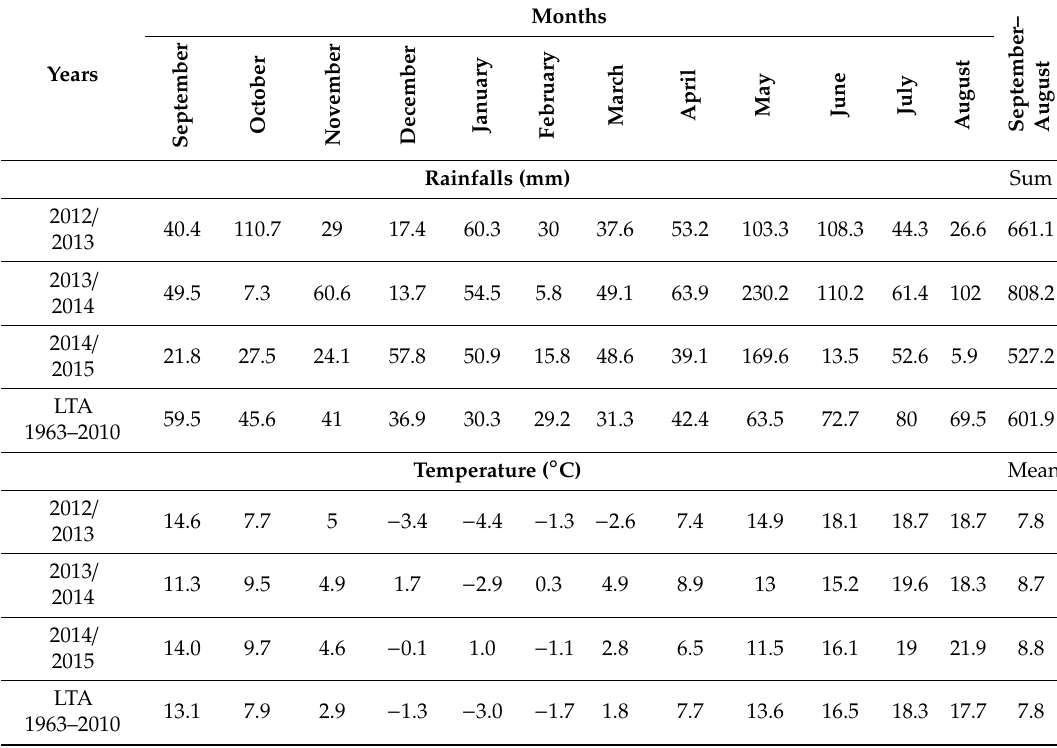
Table 1. The rainfall and mean monthly air temperature in the growing season of spelt wheat, recorded by the Meteorological Station in Czesławice (Poland). LTA is the long term